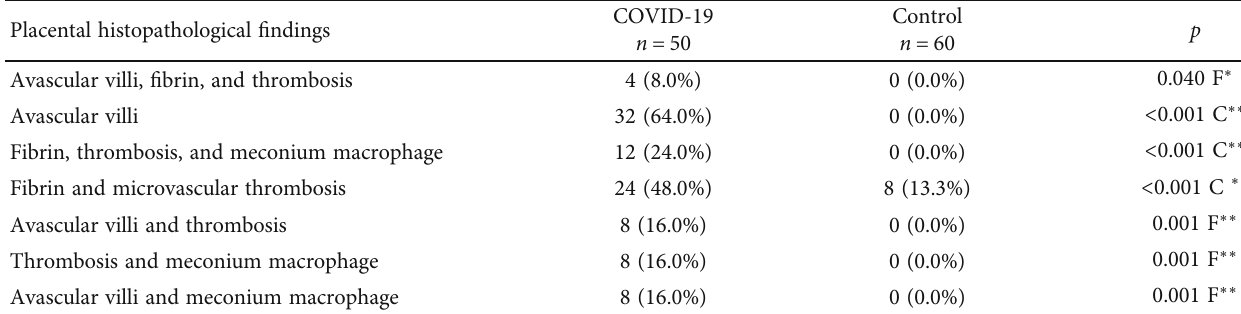
Table 3: Comparison of placental histopathological fi ndings between COVID-19 group and control group. Placental histopathological fi